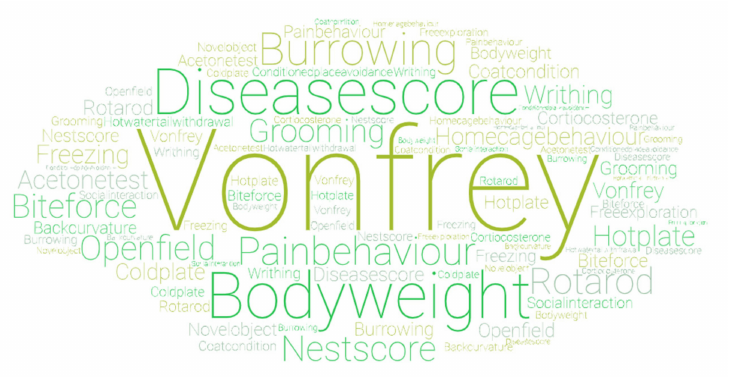
Figure 10. Word cloud illustrating corroborating methods of affective state assessment used in the included studies. Size of the word illustrates their relative frequency of use.